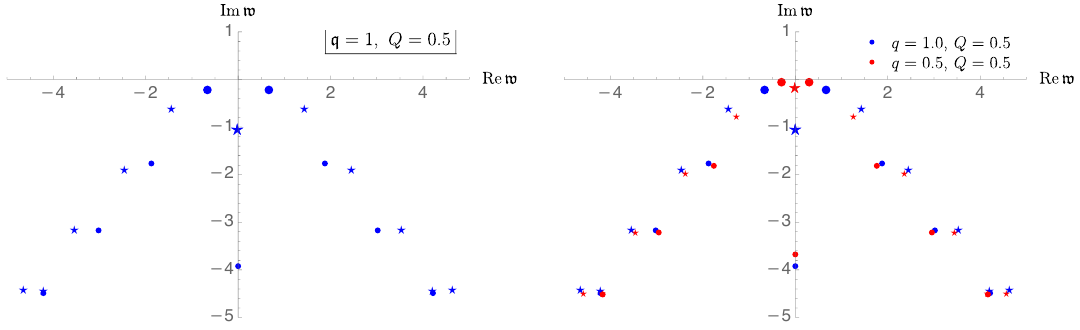
Figure 1. Left panel: stars represent poles of the master charge density Green???s function and dots correspond with poles of the master energy density Green???s function. As q decreases, all poles stay at a (cid:12)nite distance from the real axis, except for the one marked with a large star and the two marked with large dots. Large dots therefore manifest the existence of two sound modes and the large dot corresponds with the existence of a di(cid:11)usive U(1) charge mode in the boundary N = 4 SYM theory at (cid:12)nite chemical